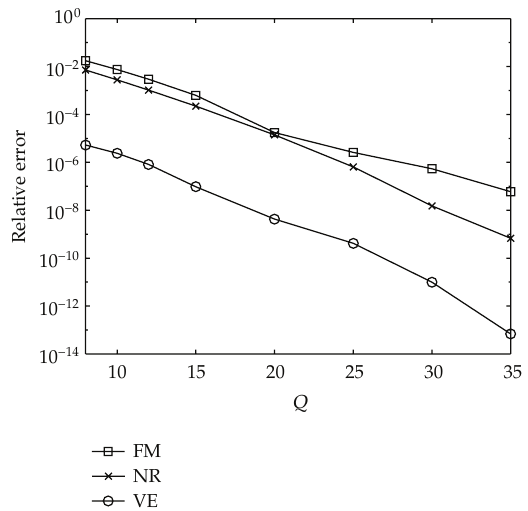
Figure 5: Relative error in P b for di ff erent techniques.